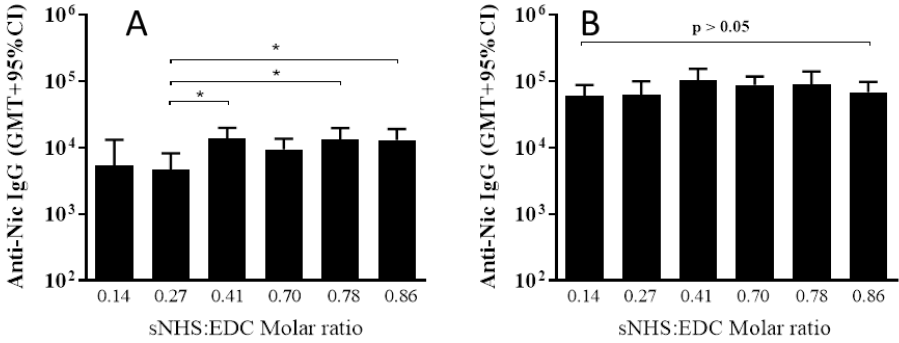
Figure 4. Effect of different sNHS/EDC ratios on antibody (Ab) titers. BALB/c mice ( n = 10/group) were immunized on Days 0 and 21 by IM injection with 10 µ g of different NIC7-CRM conjugates